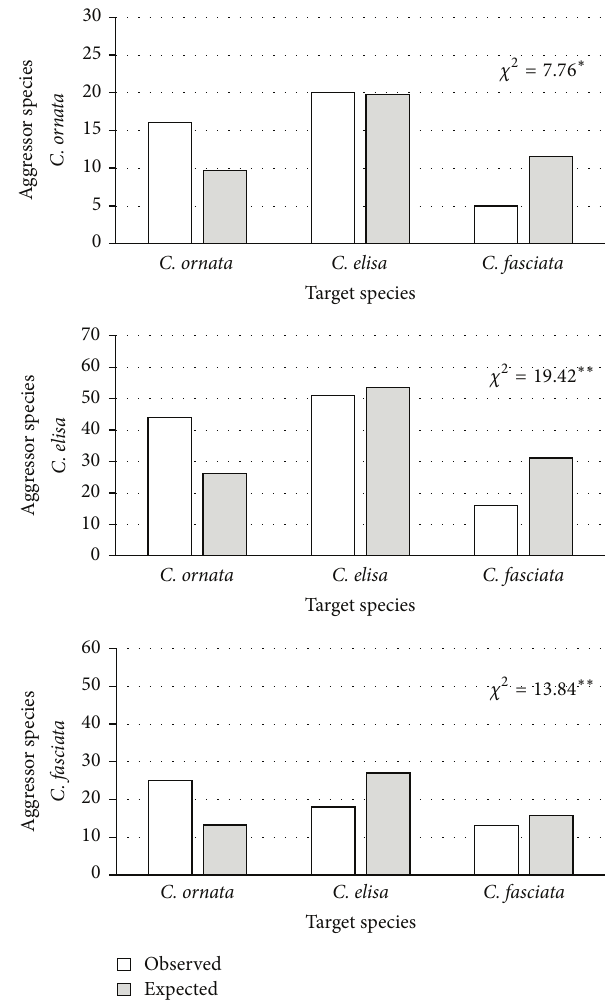
Figure 6: The frequency at which Celithemis ornata , C. elisa , and C. fasciata attacked perched individuals of these species, compared to expected frequencies based on relative mean hourly abundance counts averaged over the entire sampling period of May–July 2015 ( ∗ 𝑃 < 0.05 ; ∗∗ 𝑃 < 0.01 , chi-squared goodness of fit